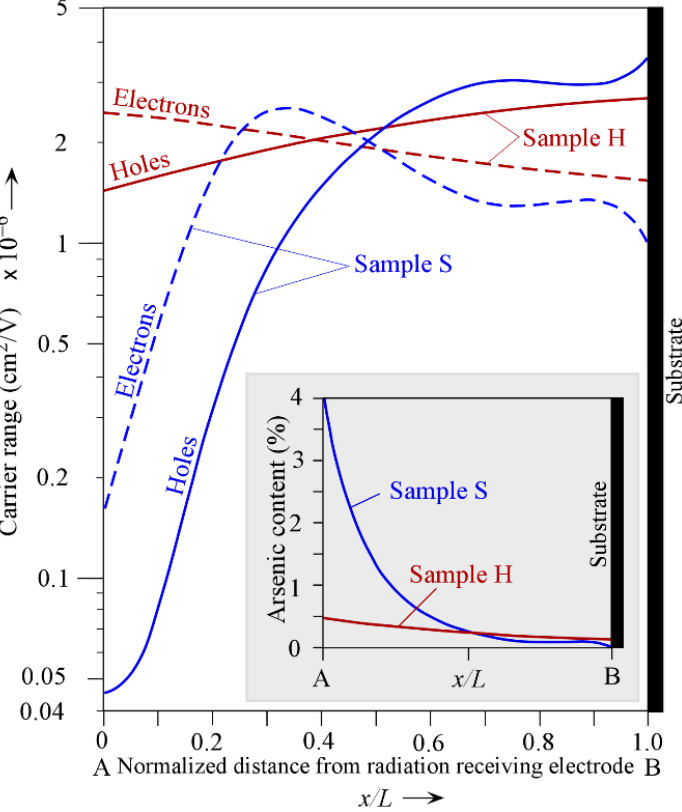
Figure 6. A semilogarithmic plot of the variation in the electron and holes ranges with normalized distance x / L from the radiation ‐ receiving electrode (towards the substrate) for the two samples H and S in Figure 1.